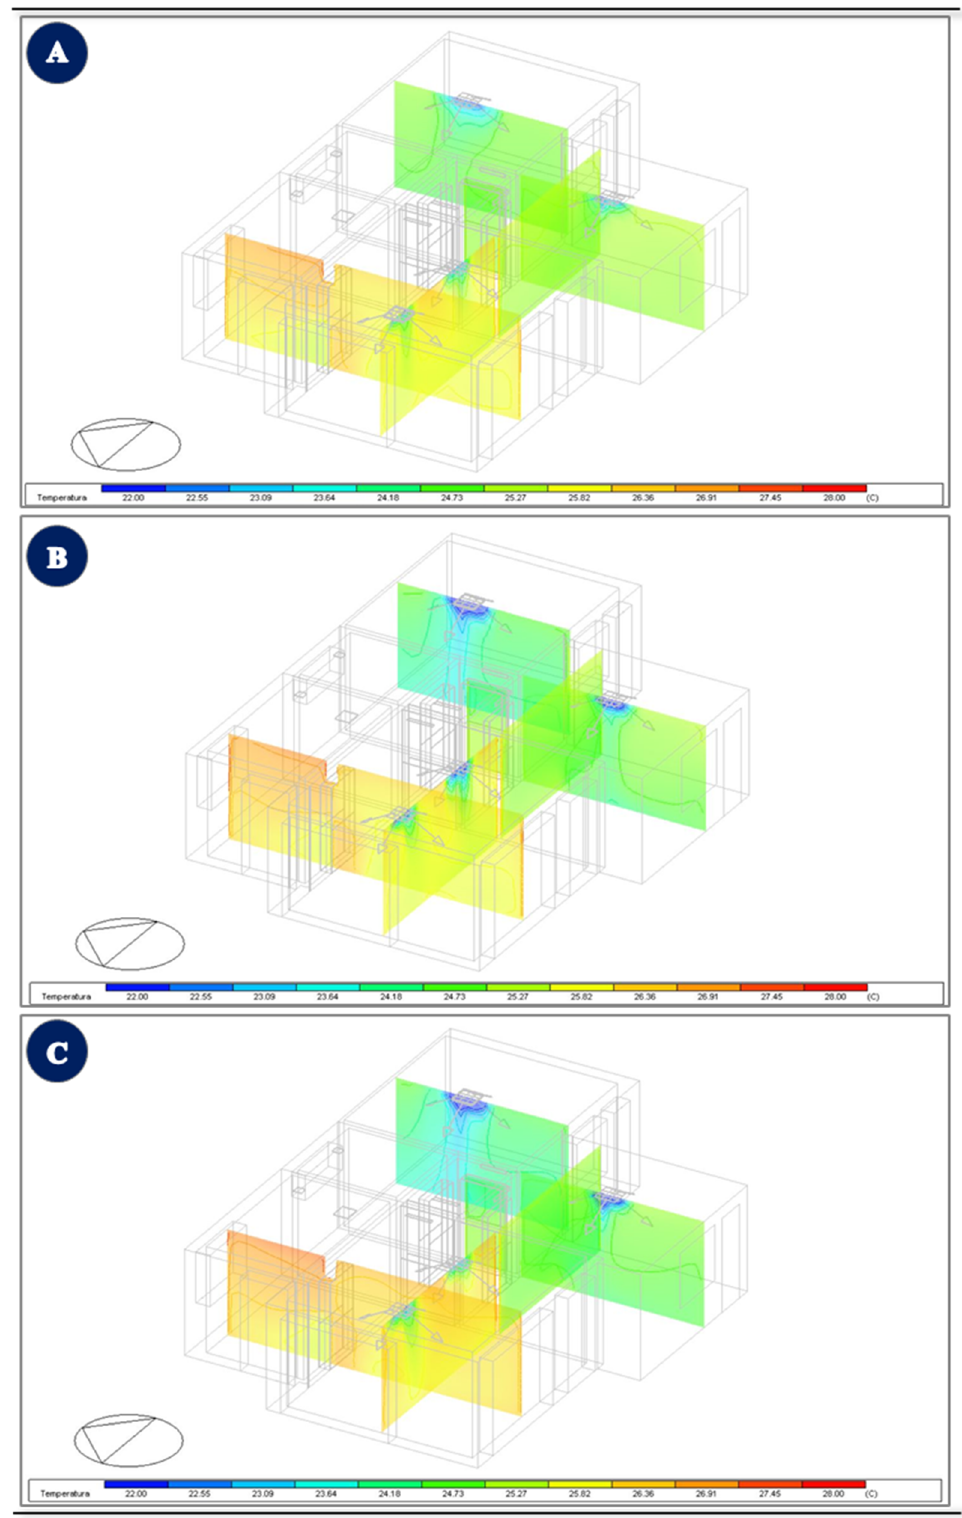
Figure 8. 2D distribution of air temperature on 17 July at ( A ) 10:00, ( B ) 14:00, and ( C ) 18:00.